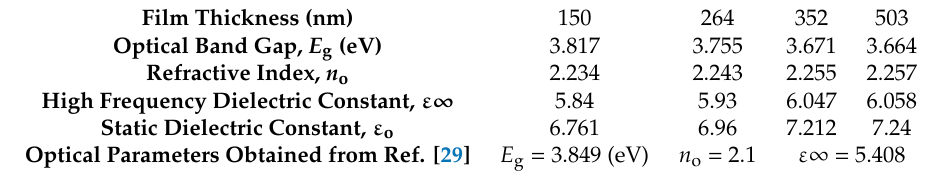
Table 3. Some optical parameters for NiO 0.96 thin films at di ff erent